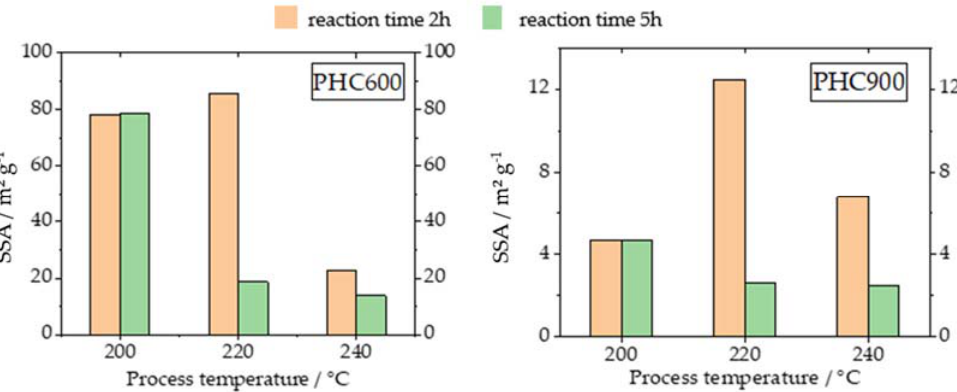
Figure 4. Specific surface areas of BET measurements with nitrogen for PHC600 and PHC900.